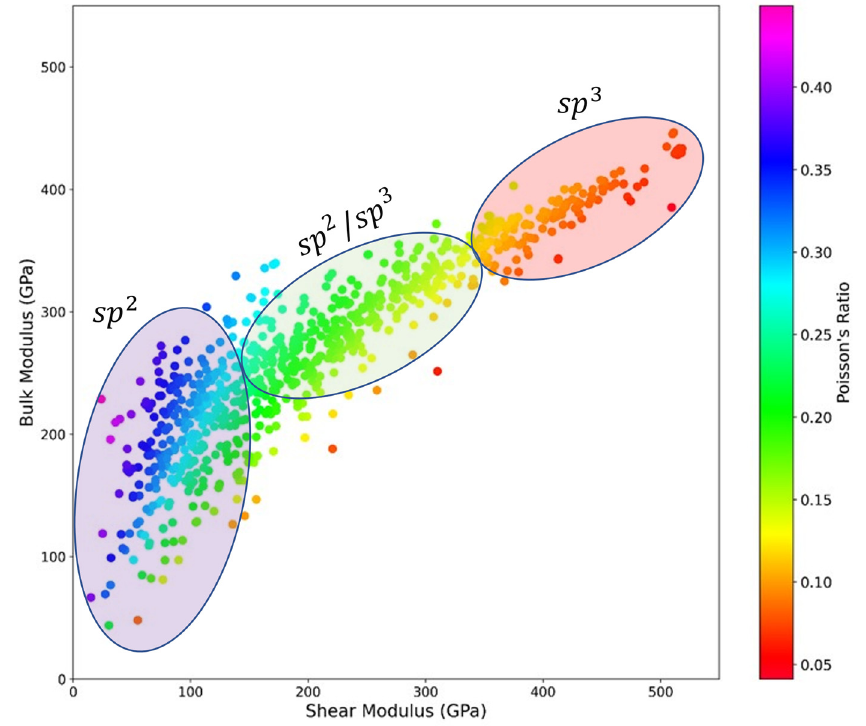
Figure 5. 2D map of bulk modulus vs. shear modulus with Poisson’s ratio as color bar to explain hardness and show the relationship between all the mentioned properties.